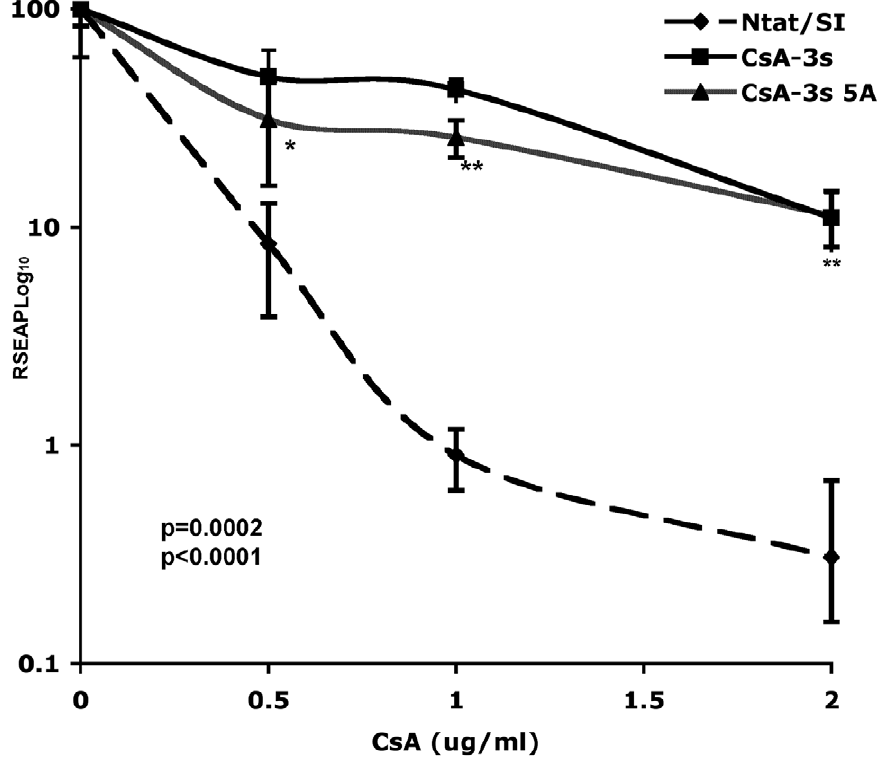
Figure 1. NS5A confers CsA resistance. Equal numbers of replicon cells were seeded for the Ntat/SI, CsA-3s and CsA-3s 5A cell lines. The cultures were treated with CsA at the indicated concentrations for 6 days. Media was changed on day 6 and CsA was added to the cells again. On day 7, media was collected and assayed for SEAP activity. They axis shows RSEAP Log10 (relative SEAP Log values). Student’s t test was used to calculate p values. Ntat/SI vs CsA-3s 5A at 1.0 and 2.0 m g/ml , 0.0001; at 0.5 m g/ml is 0.0002.